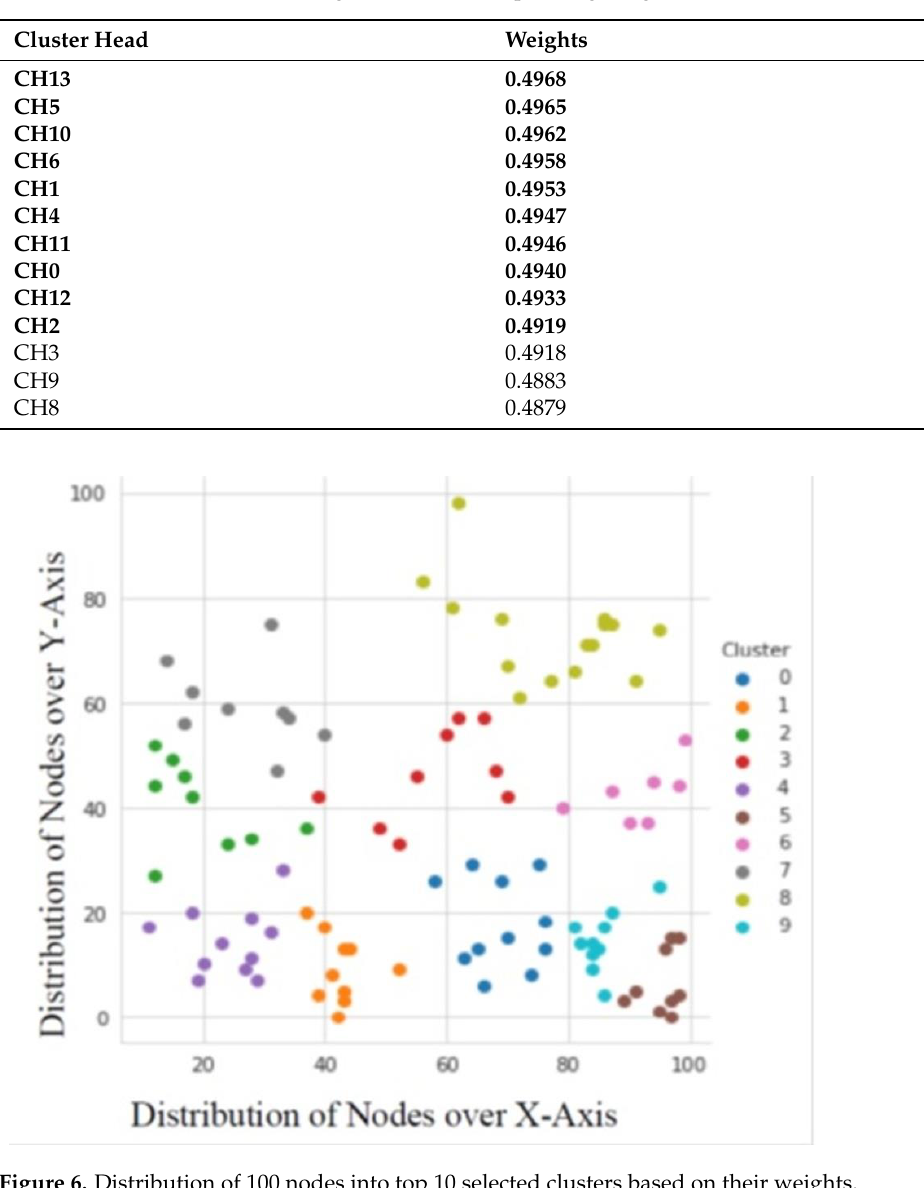
Figure 6. Distribution of 100 nodes into top 10 selected clusters based on their weights . Table 6. The 14 cluster heads along with their corresponding weights .